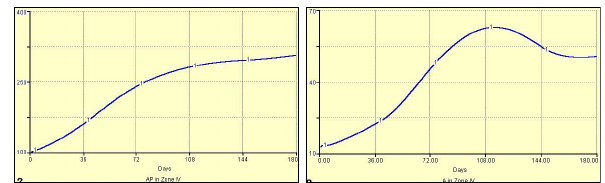
Fig. 23. Simulation results of the main ecological indexes at zone IV Figure 23. Simulation results of the main ecological indices 4. Conclusions for zone 4. (a) Aquatic plant biomass (AP); (b) phytoplankton biomass